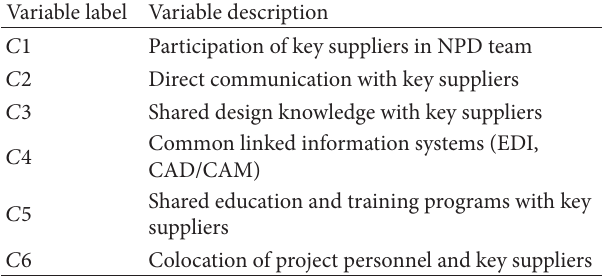
Table 1: The variables manifesting supplier involvement practices. Variable label Variable description